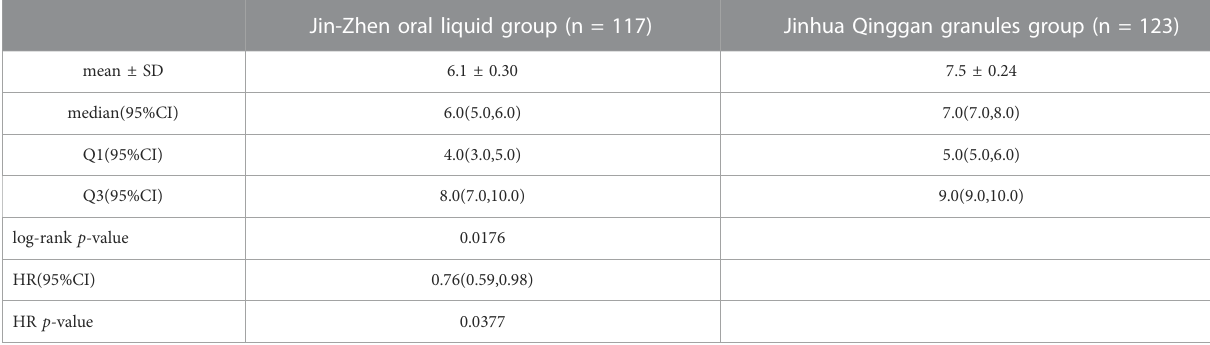
TABLE 2 The time to fi rst negative viral testing in two groups (FAS).